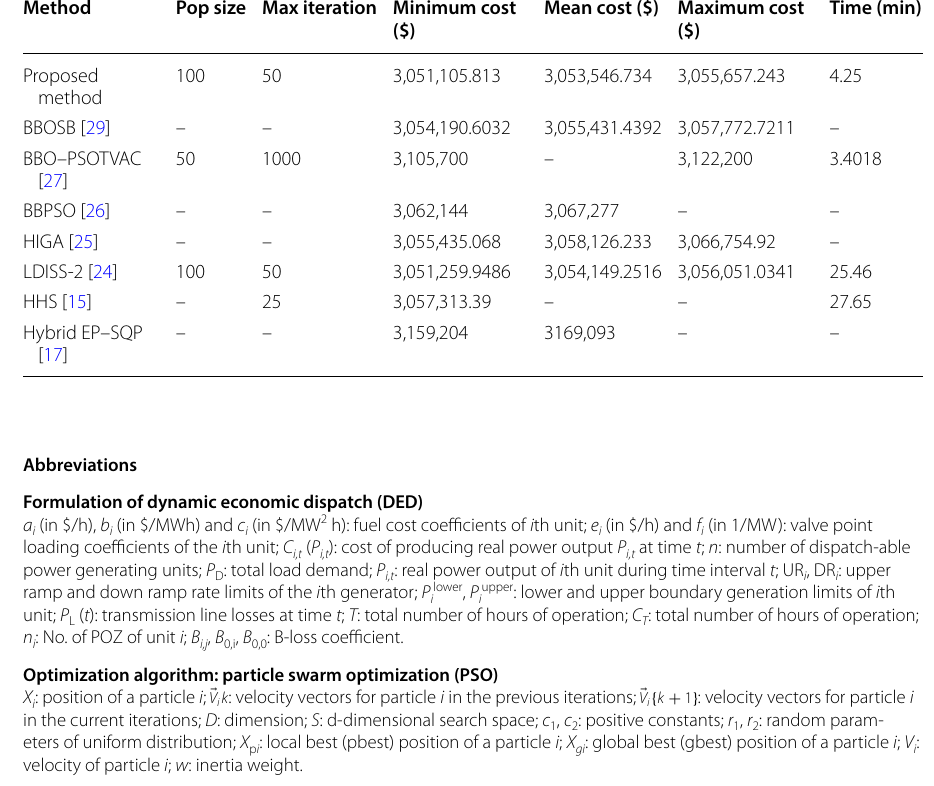
Table 16 Cost comparison of optimization results for 30-unit test system